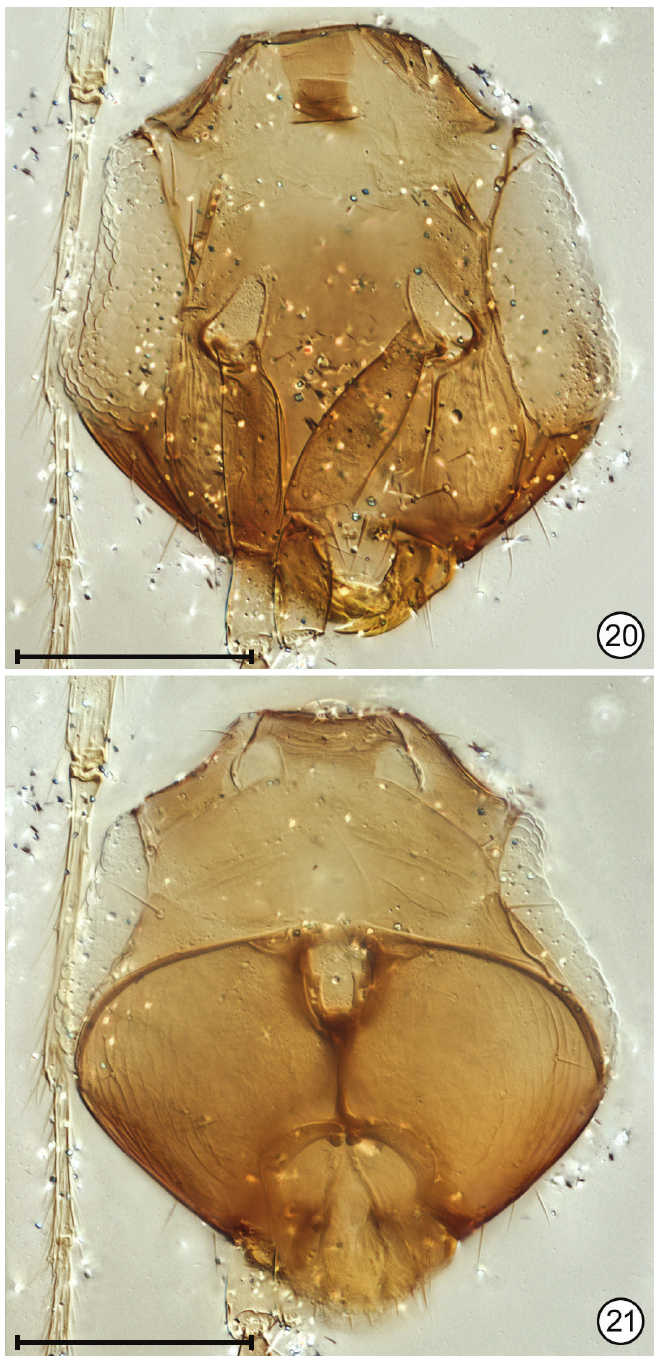
Figures 20, 21. Paranaphoidea africana holotype 20 head, anterior 21 head, posterior as seen through head. Scale bars: 100